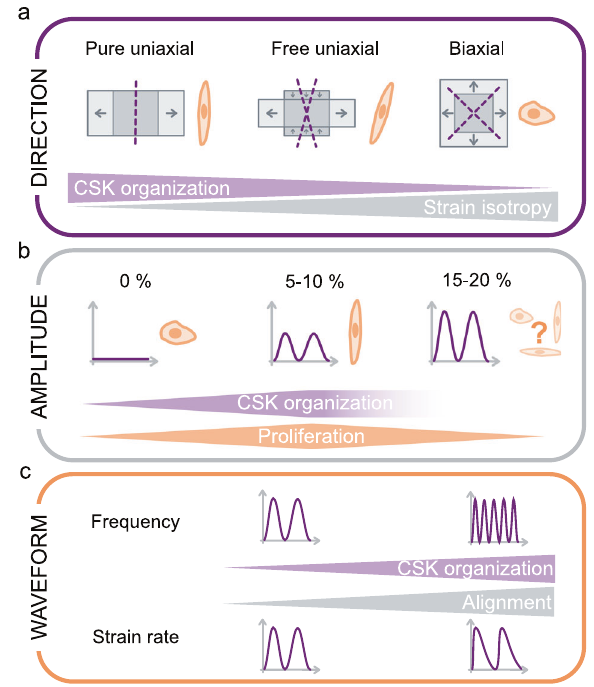
Fig. 4 Features of tensile stresses experienced by endothelial cells. a Strain direction can be purely uniaxial, free uniaxial (with an additional lateral compression), or biaxial (isotropic). Purple dotted lines indicate minimum strain direction. Strain direction in fl uences cytoskeletal (CSK) organization. b Strain amplitude in fl uences cytoskeletal organization and cell proliferation, which are maximized for intermediate strain amplitudes. c Strain frequency and strain rate in fl uence cytoskeletal organization and cell